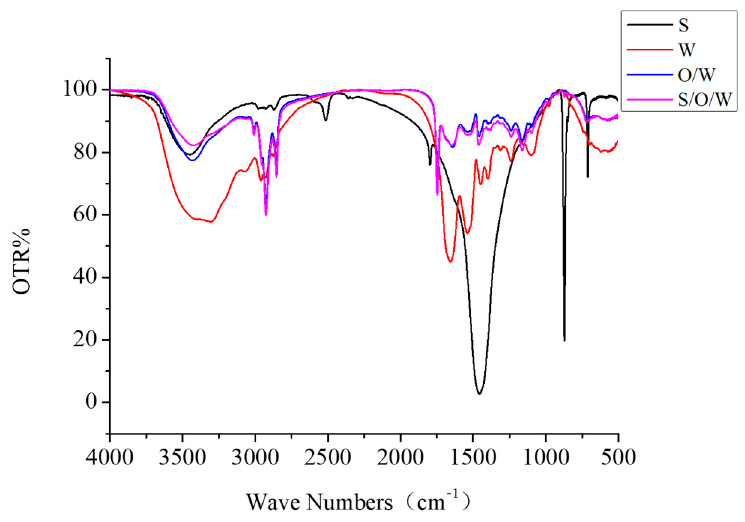
Figure 7. The infrared spectrum results of S phase, W phase, O/W emulsions, and S/O/W emulsions. The characteristic absorption peaks of NaCas (W phase) appeared at 3306.28 cm − 1 , 2961.05 cm − 1 , 1655.03 cm − 1 , 1539.57 cm − 1 , 1448.47 cm − 1 , 1398.40 cm − 1 , 1241.17 cm − 1 , 1102.62 cm − 1 , and 573.57 cm − 1 , among which the stretching vibration of the O-H bond ap- peared at 3306.28 cm − 1 ; the stretching vibration peak of C-H bond appeared at 2961.05 cm − 1